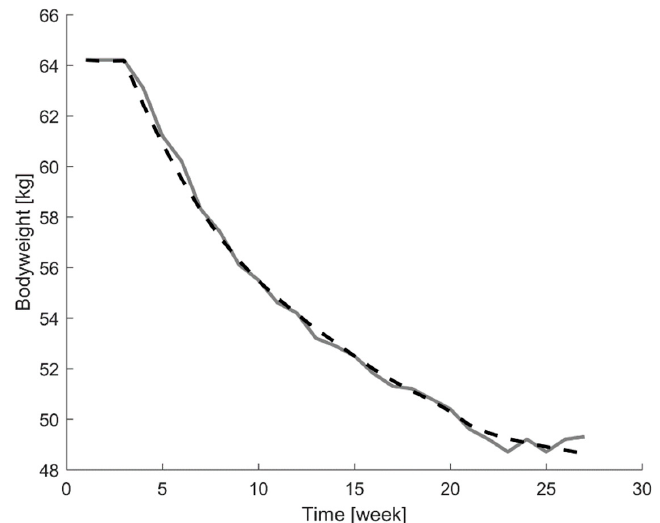
Figure 2. Comparison between the bodyweight curved collected for test participant 8 in the Minnesota starvation experiment (solid line) and the bodyweight curve simulated by a first order time-invariant parameters transfer function model (dashed line).